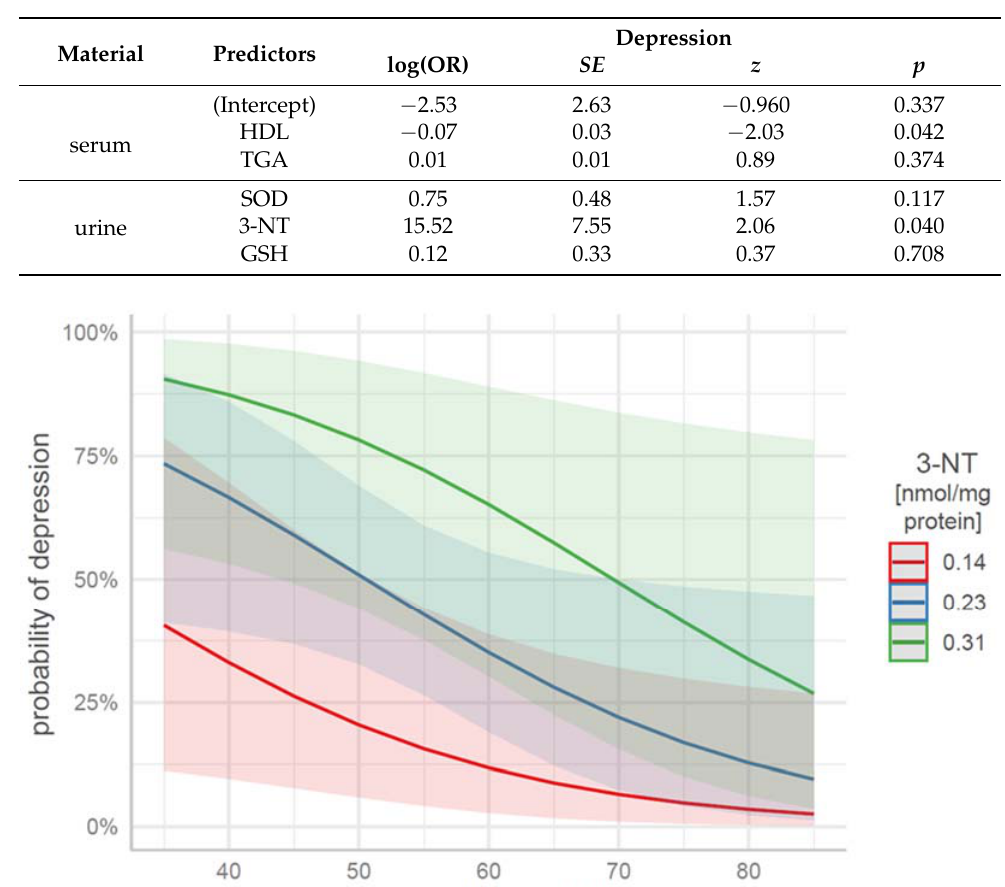
Table 3. From the data in Table 3, it is shown that the parameters TGA, SOD, and GSH had no significant effects on the depression factor. A 1.00 mg/dl increase in the HDL parameter decreased the log odds ratios of depression by 0.07—provided the other predictors were controlled for—as shown here and below. Increasing parameter 3 NT by 1.00 nmol/mg protein increased the log odds ratios of depression by 15.52.